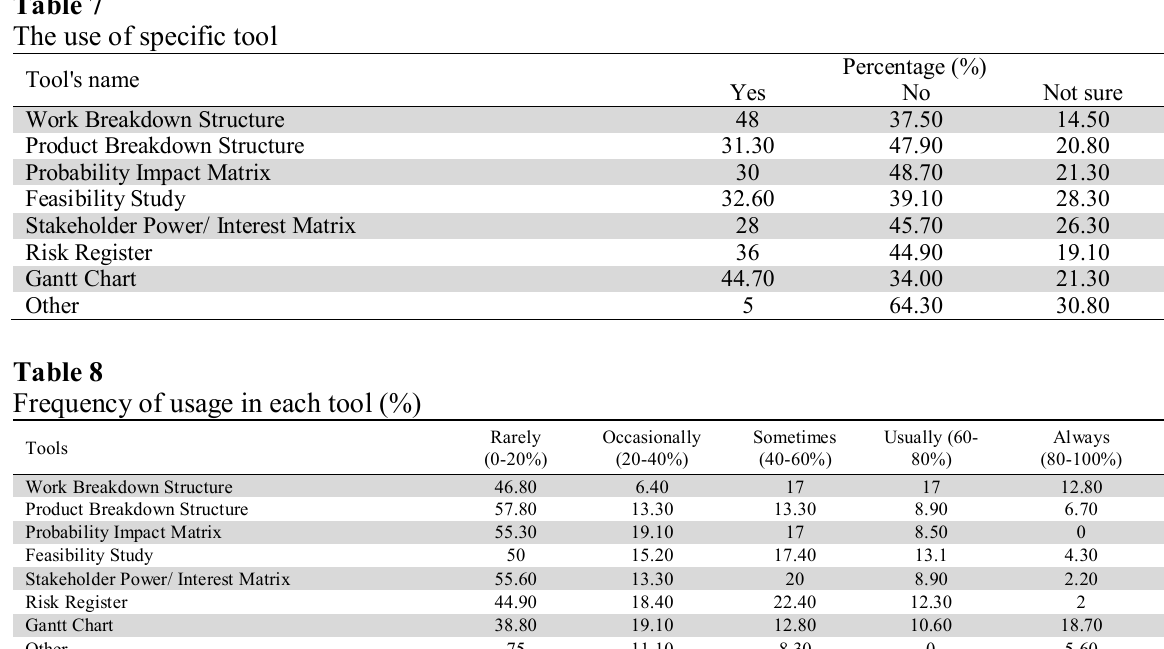
The importance of each attribute in using and applying PTTs (%) Importance Level Quite important